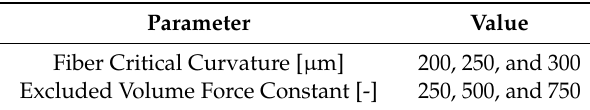
Table 2. Values varied in simulation.